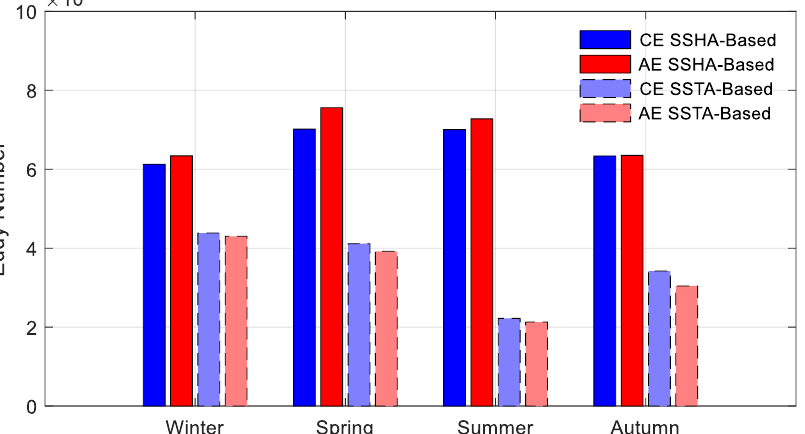
Figure 8. Seasonal statistical graph of the number of cyclonic (CE) and anticyclonic (AE) eddies from SSHA- and SSTA-based eddy trajectories with lifetime ≥ 30 days. Here, the “eddy” is distinguished from eddy trajectory, which is the result of eddy identified from the daily SSHA or SSTA field.